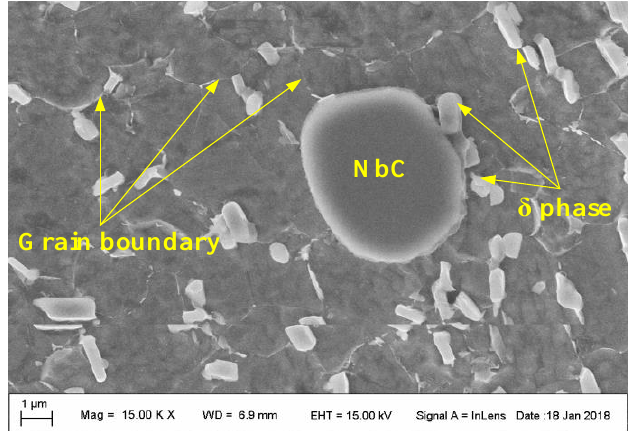
Figure 1. SEM observation of GH4169 alloy microstructure.